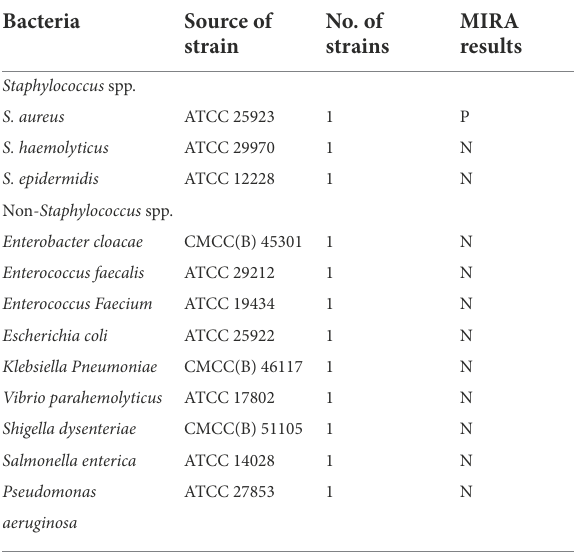
TABLE 1 Bacterial strains used in this study and results of analytical specificity of MIRA